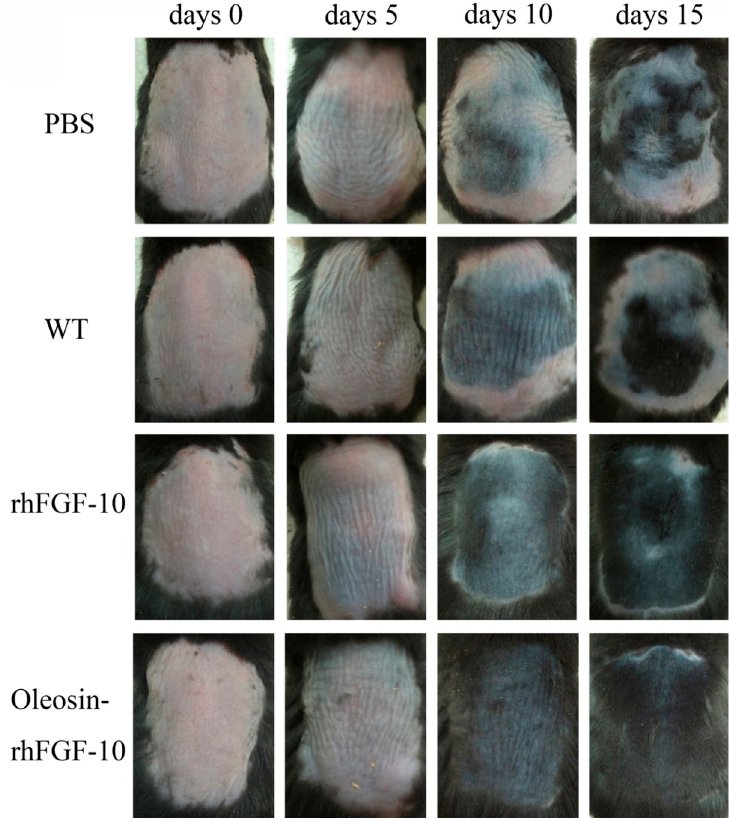
Figure 8. The effect of oleosin-rhFGF-10 on hair growth. Sequential photographs showing hair growth following four treatments, on days 0, 5, 10 and 15. The color of the skin changes from pink to black with the regeneration of hair follicles.